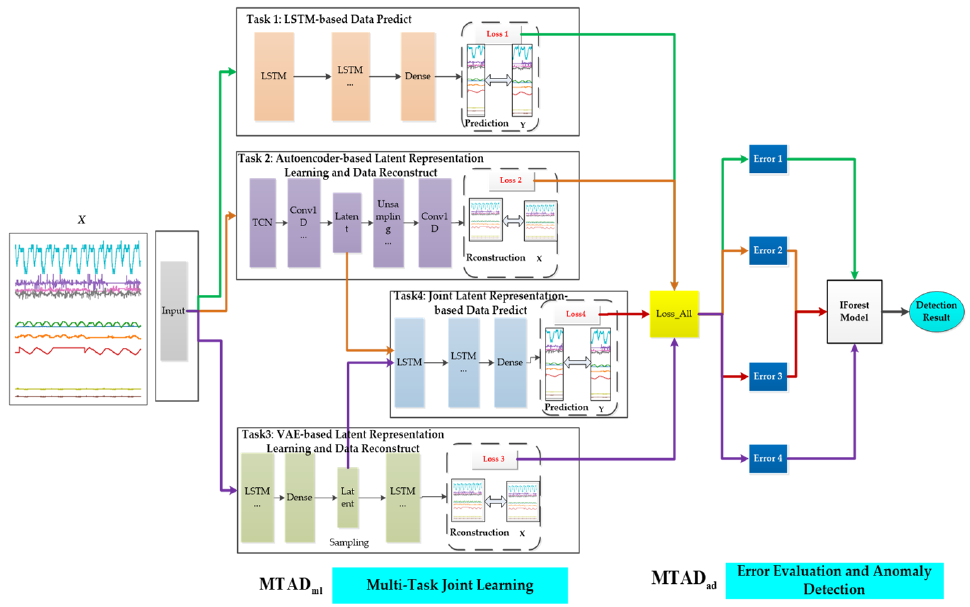
Figure 1. Overall structure of proposed MTAD method.